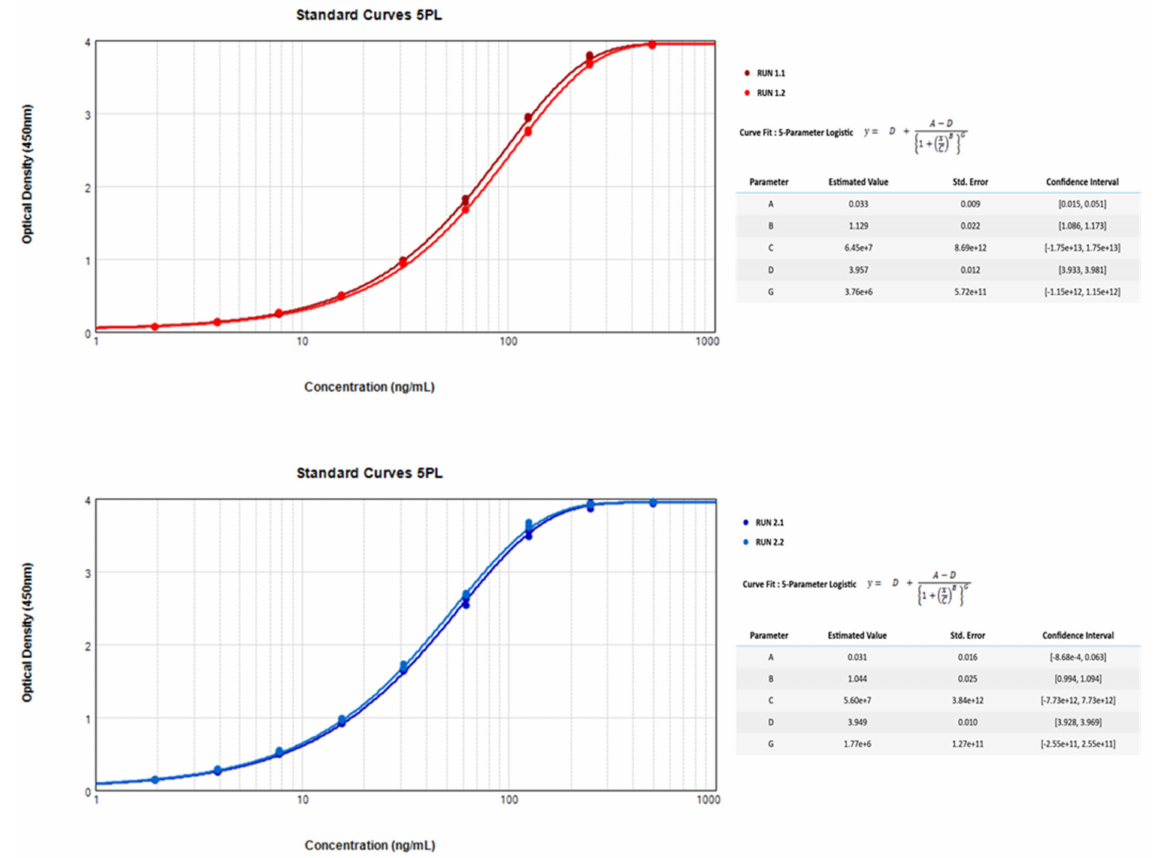
Figure 1. Graphical representation by a 5 Parameter Logistic (5PL) Curve of the Results for the various standard curves across the range of 1.953 ng/mL to 500 ng/mL human-specific IgG against the SARS-CoV-2 spike protein.